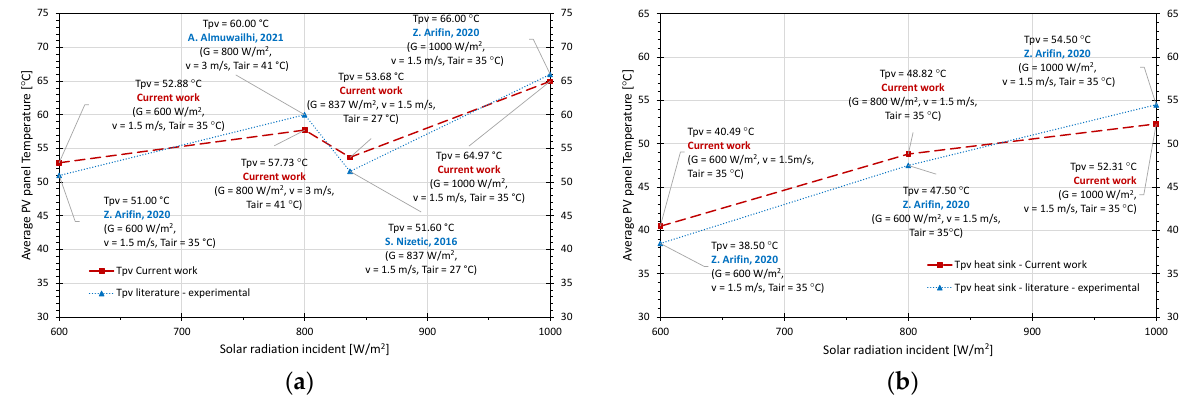
Figure 7. Validation of the model: ( a ) base case—without heat sink; ( b ) PV panel with heat sink.